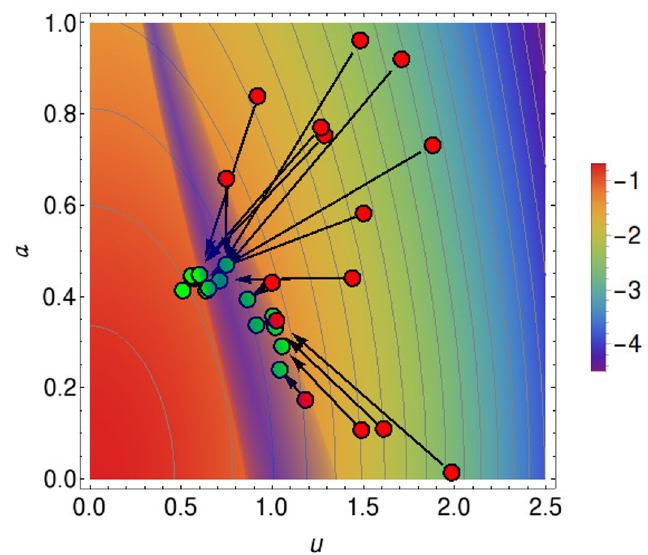
Figure 11 . Entropic attractor in collisions 2 ! 1 ! 2 with J=M = 3 : 8. See (cid:12)gure 1 for the explanation. The attractor is less strong as J=M grows larger. Note that initial states to the left of the purple band have large initial impact parameters and the black holes do not merge, so we do not include